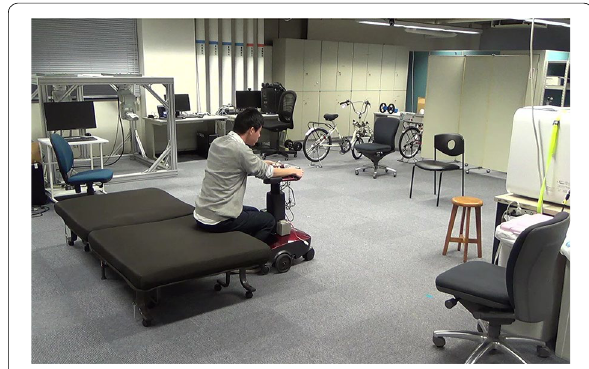
Fig. 11 Experimental setup. Participants sit and stand from all chairs and bed using the robot